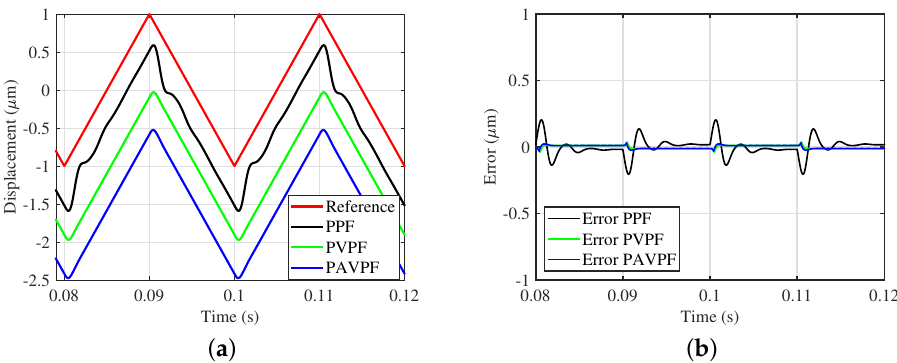
Figure 7. ( a ) Time domain traces by the proposed PPF, PVPF and PAVPF controllers for 50 Hz triangular wave input; ( b ) Measured error by proposed PPF, PVPF and PAVPF controller for 50 Hz triangular wave input.